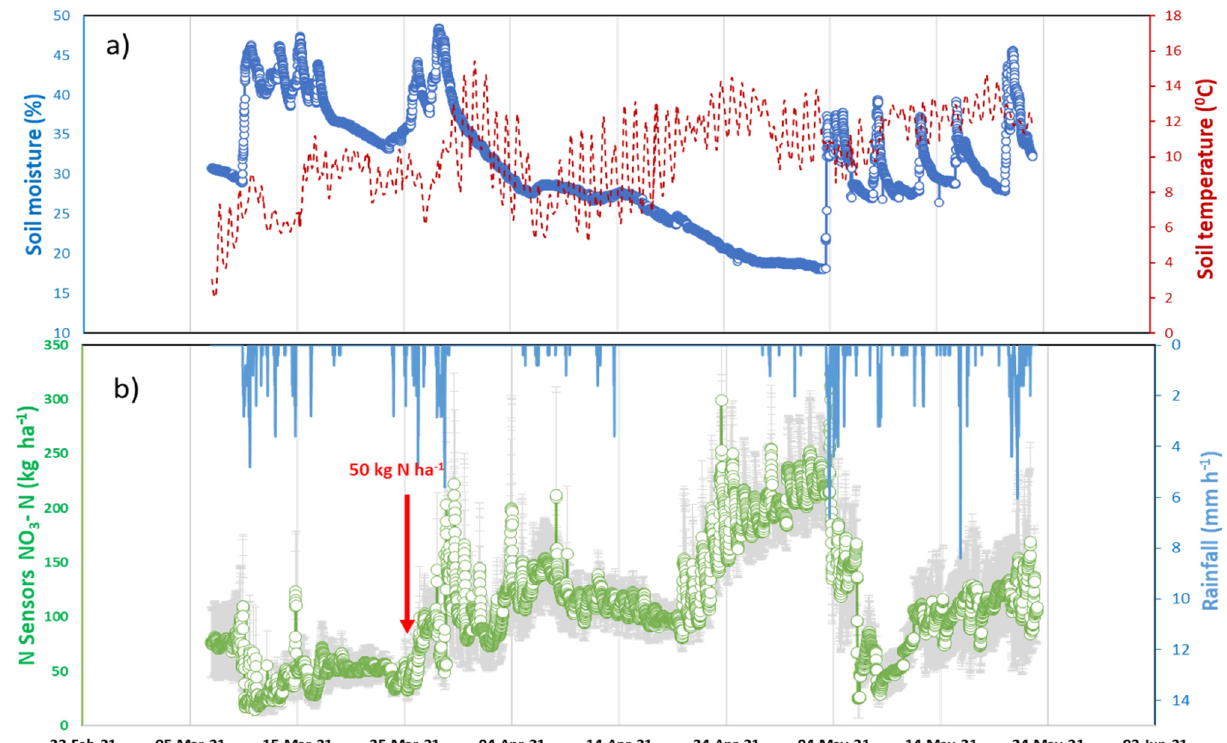
Figure 11. Sample results from Henfaes deployment: ( a ) soil sensor temperature and moisture; ( b ) soil sensors nitrate measurements with fertiliser applications highlighted, plotted against the rainfall. (See Table S4).